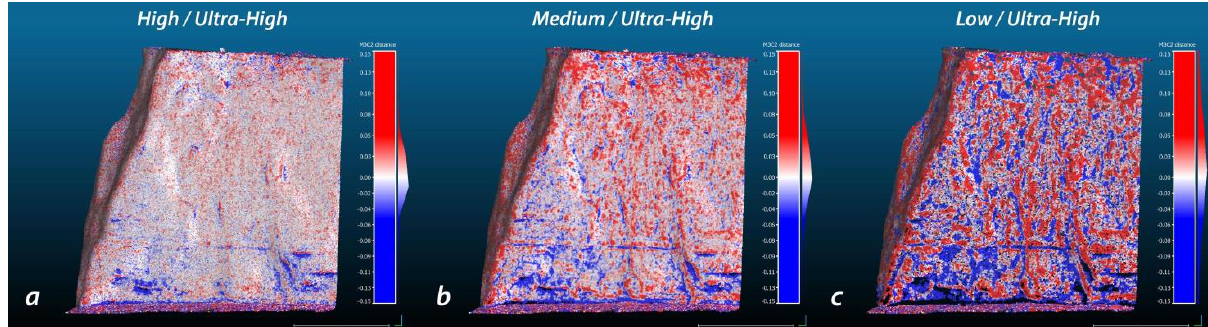
Figure 4 : Effect of decreasing point cloud density in Photoscan. Three reduced resolutions (High, Medium, Low) are compared with the densest possible model (Ultra-High). It turns out that topography is expectedly smoothed with lower densities along sharp edges, but a zebra-skin effect appears on either sides of sharp gradients. cliff height (median = 17 mm between adjacent points) while TLS point cloud has a median density of 41mm but varies with